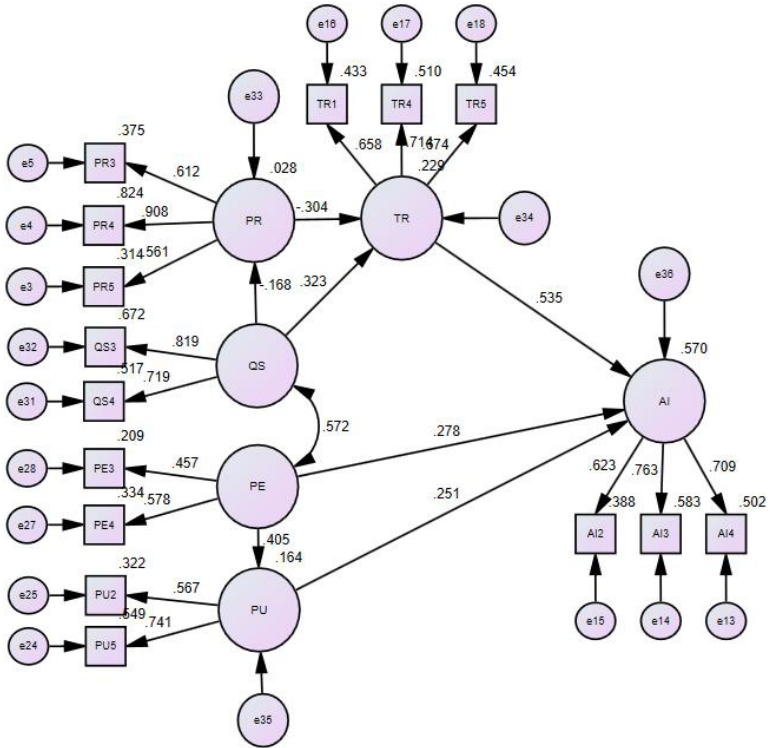
Fig. 4 The proposed model in SEM with standardised estimates